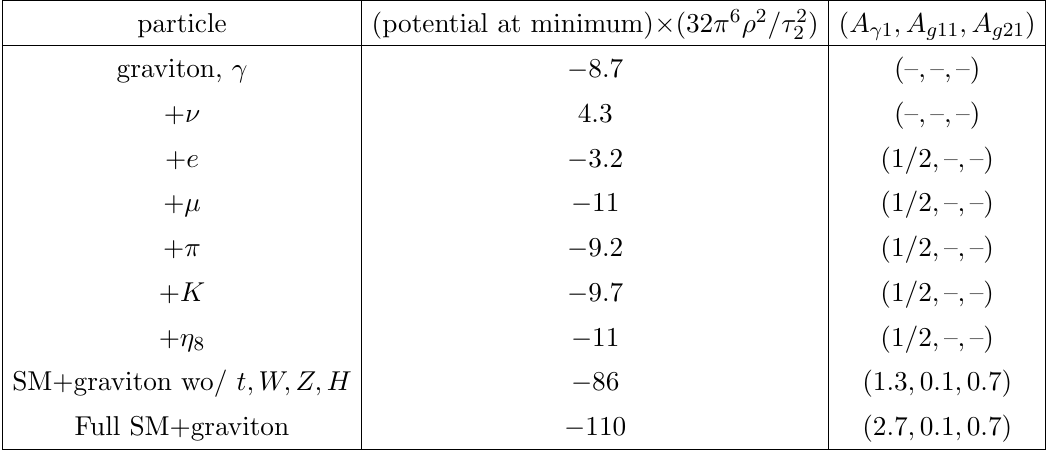
Table 4 . The minimum of eq. (4.15) as a function of the Wilson line is shown. Here the neutrino is periodic and Majorana. The third column is the value of the Wilson line (cid:12)eld corresponding to the